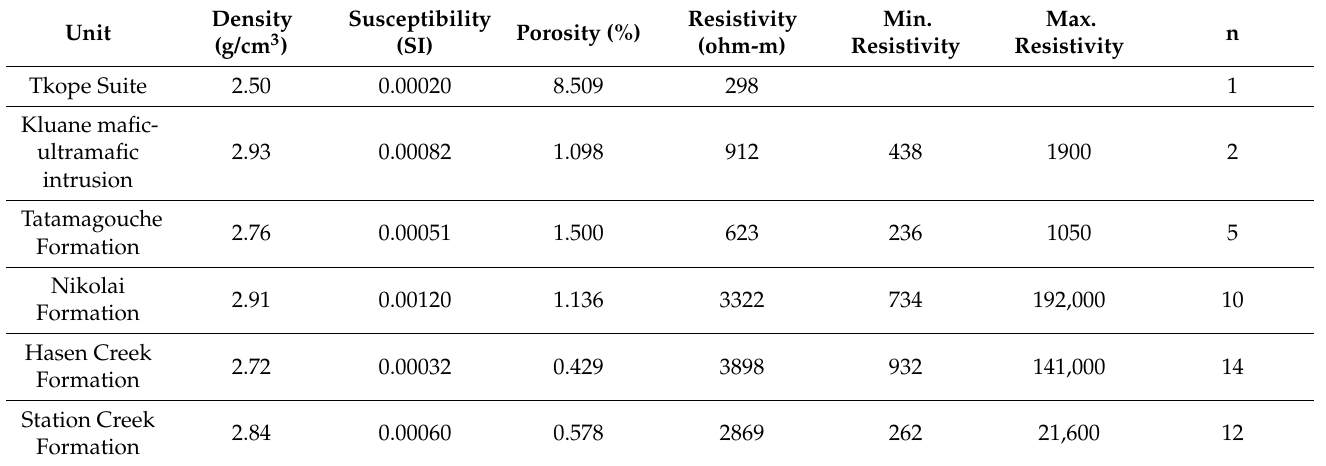
Table 1. Physical rock properties of the study area. Measurements made using the techniques described in [54] (Supplementary